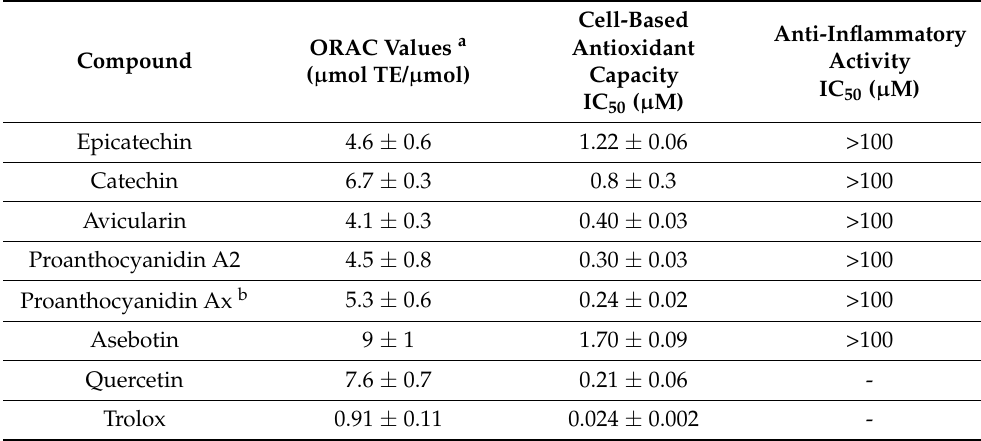
The positive controls, quercetin and Trolox, presented ORAC values of 7.6 ± 0.7 and